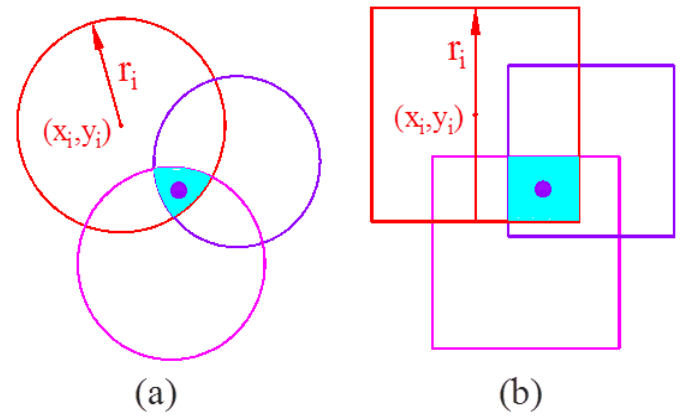
Figure 2. The intersection process: ( a ) circle case, ( b ) square case.